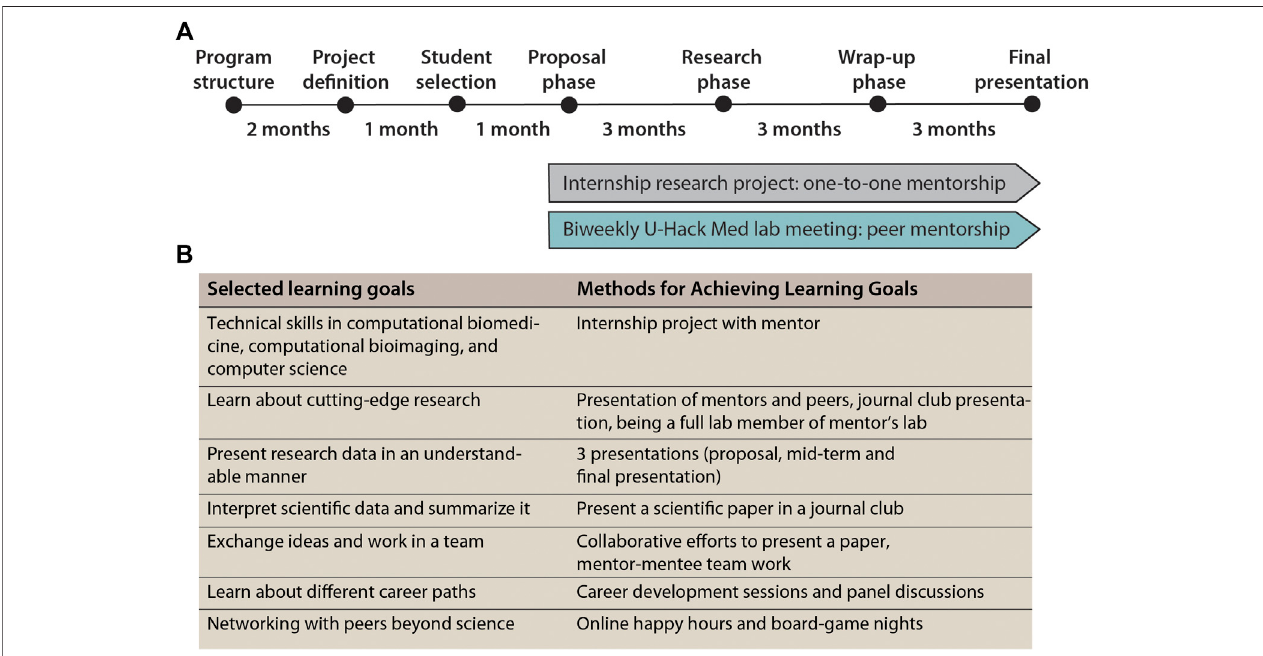
FIGURE 1 | Project milestones and learning goals. (A) Schematic of important milestones of the U-Hack Gap Year internship program (B) Summary of the major learning goals for the undergraduate